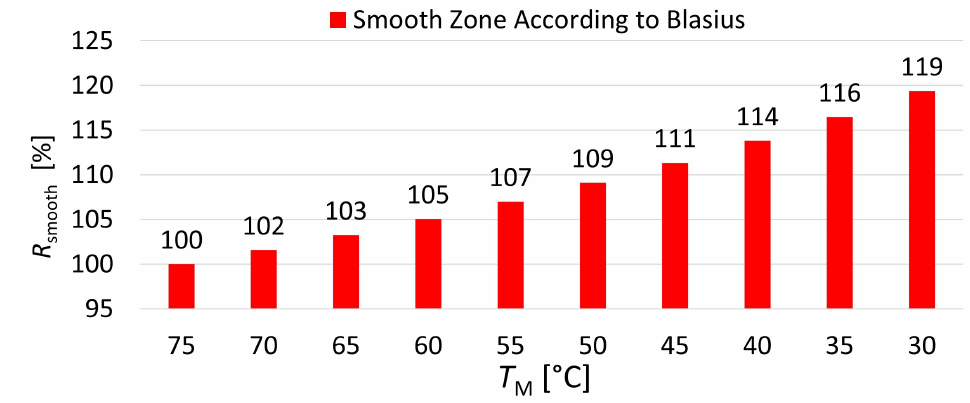
Figure 3. Relative pressure drop R for different mean heating element temperatures T